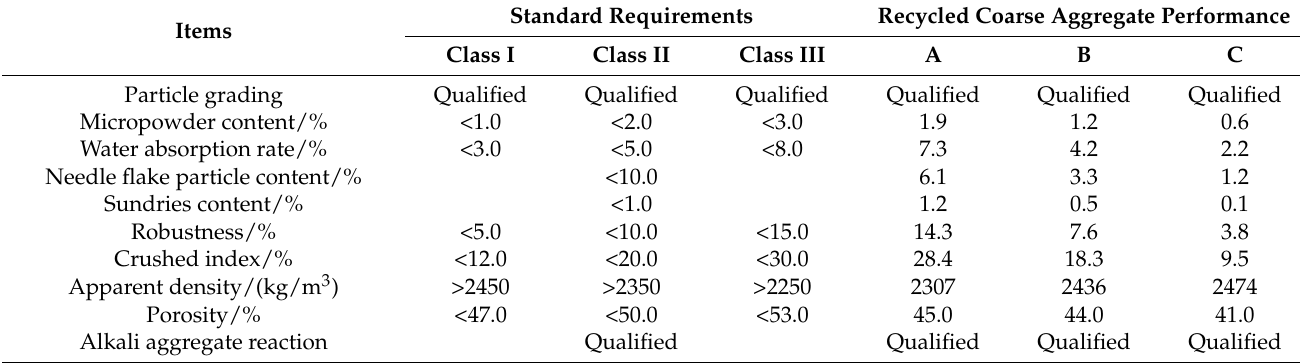
Table 1. Basic performance and evaluation of different recycled coarse aggregates.